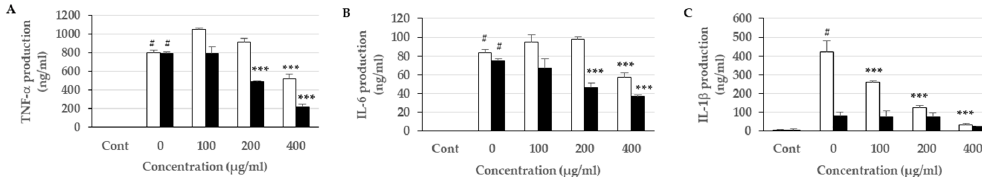
Figure 3. E ff ects of the extracts on ( A ) TNF- α , ( B ) IL-6, ( C ) IL-1 β production in LPS-stimulated RAW 264.7 macrophages. Cytokines present in the culture media were measured using ELISA. White bar represents P. granatum , black bar represents P. Guajava (Significant versus the non-treated control, # p < 0.001, Significant versus LPS treatment, * p < 0.05, ** p < 0.01 and *** p < 0.001.)